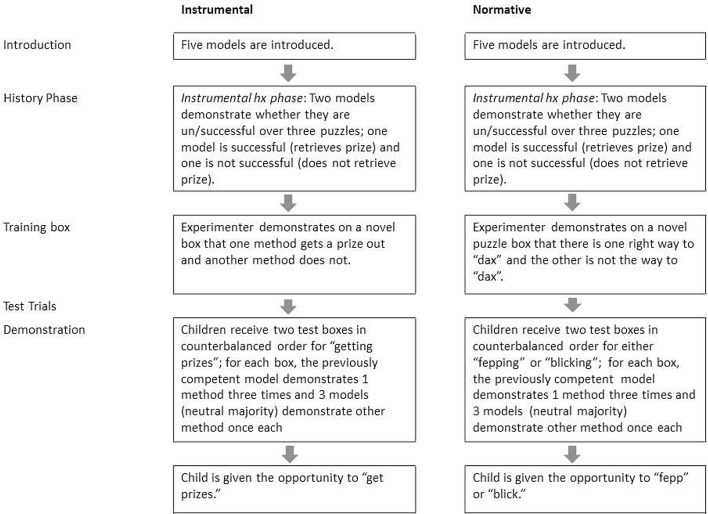
Design of Experiment 2.